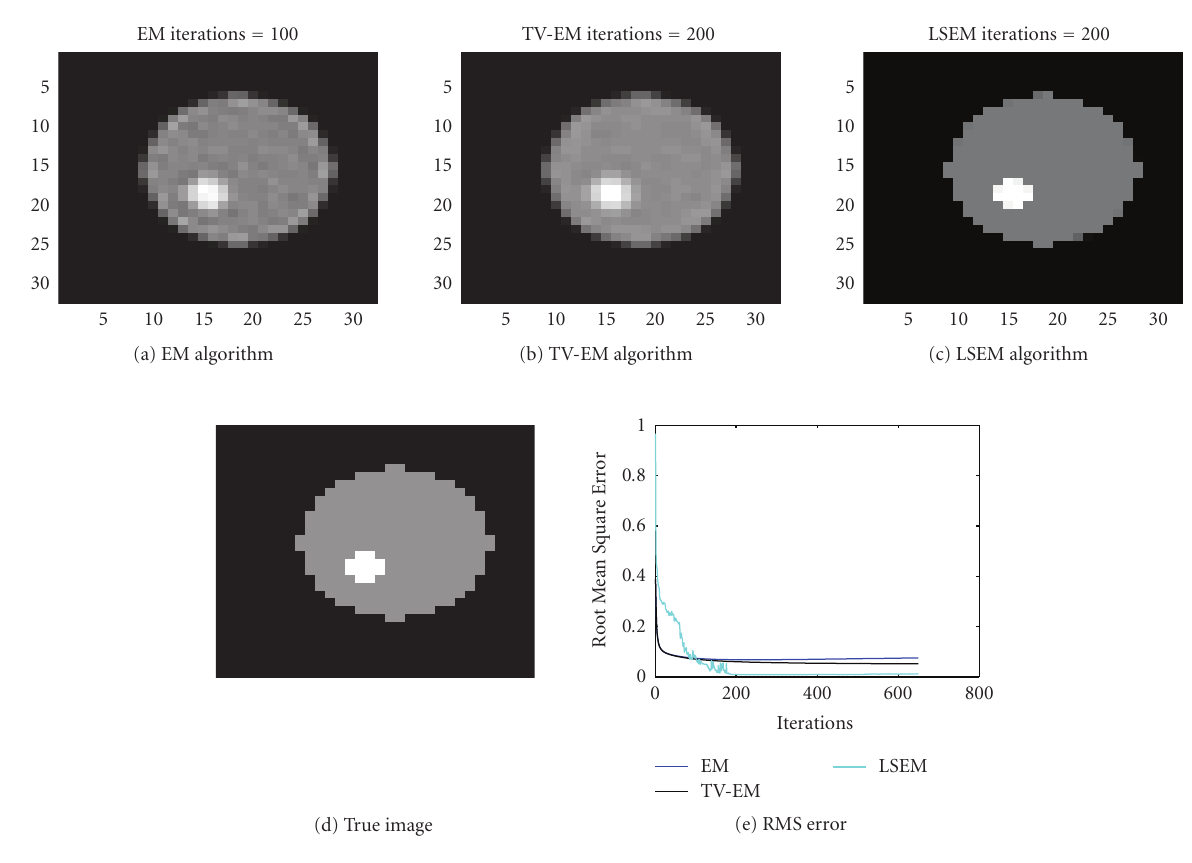
Figure 5: PET image of two circles constructed with di ff erent algorithms.